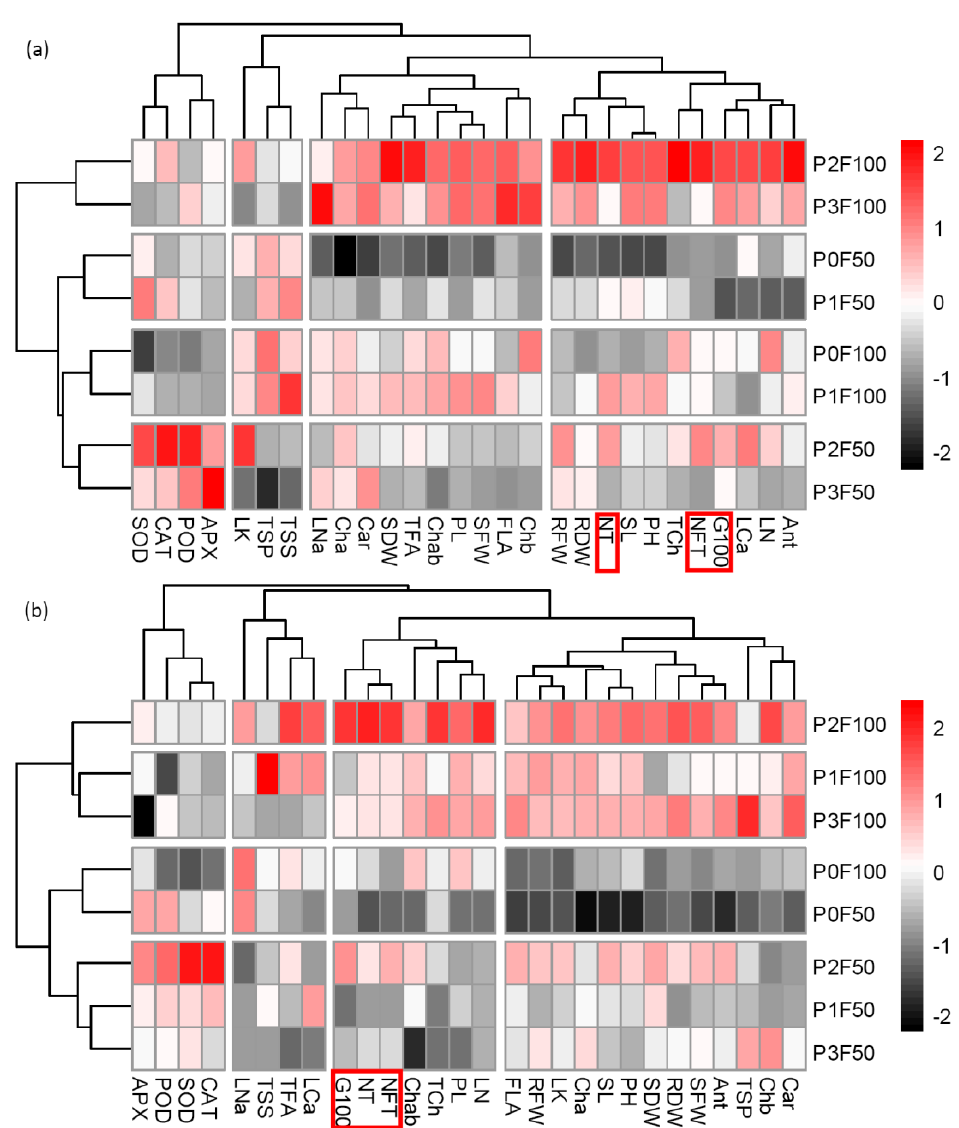
Figure 7. Heatmap clustering shows the growth and yield regulation of ( a ) FSD−2008 and ( b ) Anaj−2017 wheat varieties through laser priming−induced modulation of physiological attributes under drought stress. The yield attributes are included in the box(es). Priming: P0F100 = unprimed seeds with 100% field capacity (FC), P0F50 unprimed seeds with 50% FC, P1F100 = 1 min priming with 100% FC, P1F50 = 1 min priming with 50% FC, P2F100 = 2 min priming with 100% FC, P2F50 = 2 min priming with 50% FC, P3F100 = 5 min priming with 100% FC, P3F5 0 = 1 min priming with 50% FC. Plant attributes: PL = plant root length, SL = plant shoot length, PH = plant height, RFW = root fresh weight, SFW = shoot fresh weight, RDW = root dry weight, SDW = shoot dry weight, LN = no. of leaves, FLA = flag leaf area, Cha = chlorophyll a, Chb = chlorophyll b, Chab = chlorophyll a/b, TCh = total chlorophyll, Car = carotenoids, Ant = anthocyanin, TSP = total soluble proteins, TSS = total soluble sugars, TFA = total free amino acids, SOD = superoxide dismutase, POD = peroxidase, CAT = catalase, APX = ascorbic acid peroxidase, LNa = leaf sodium ions, LK = leaf potassium ions, LCa = leaf calcium ions, NT = no. of tillers, NFT = no. of fertile tillers and G100 = 100 g grain weight. capacity level against 50% filed capacity level in FSD−2008. Leaf potassium was increased by 26.69% under 2 min laser priming in water−stressed plants, while leaf calcium was maximally increa sed (45.45%) at the same (2 min) laser exposure time. In Anaj−2017, leaf Ca and Na contents were reduced by 36.20% and 80.95% under 2 min laser priming level under drought stress (50% field capacity).